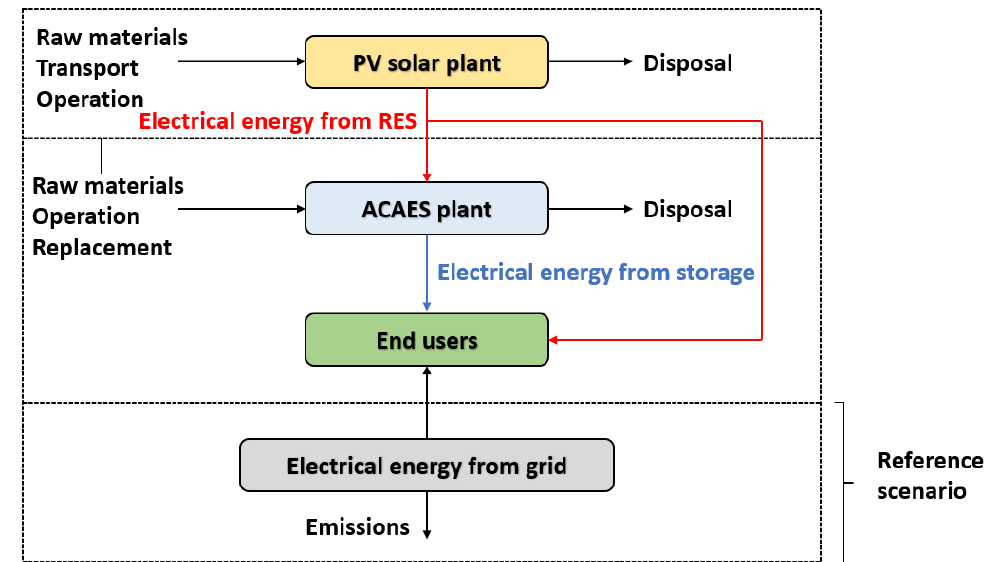
Figure 4. Boundaries of the system.